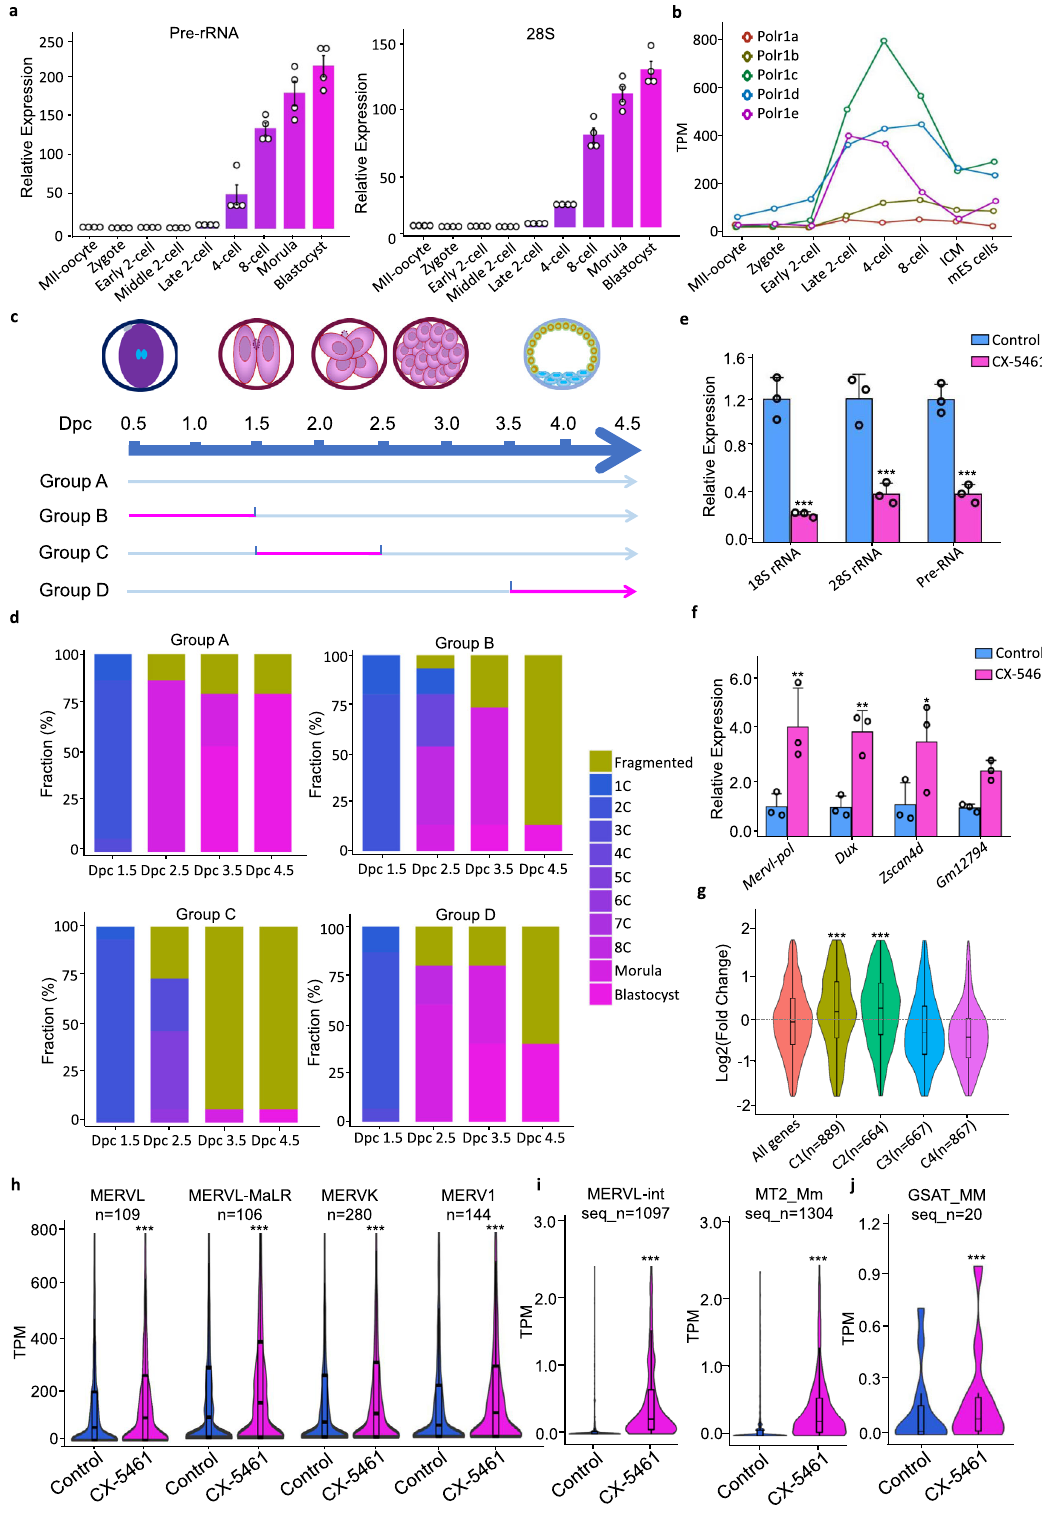
incubated for 4 h. After washing three times with PBS, DAPI was used for nucleus staining. fi xed at least 6 h at 4°C. Next, the cell samples were treated with